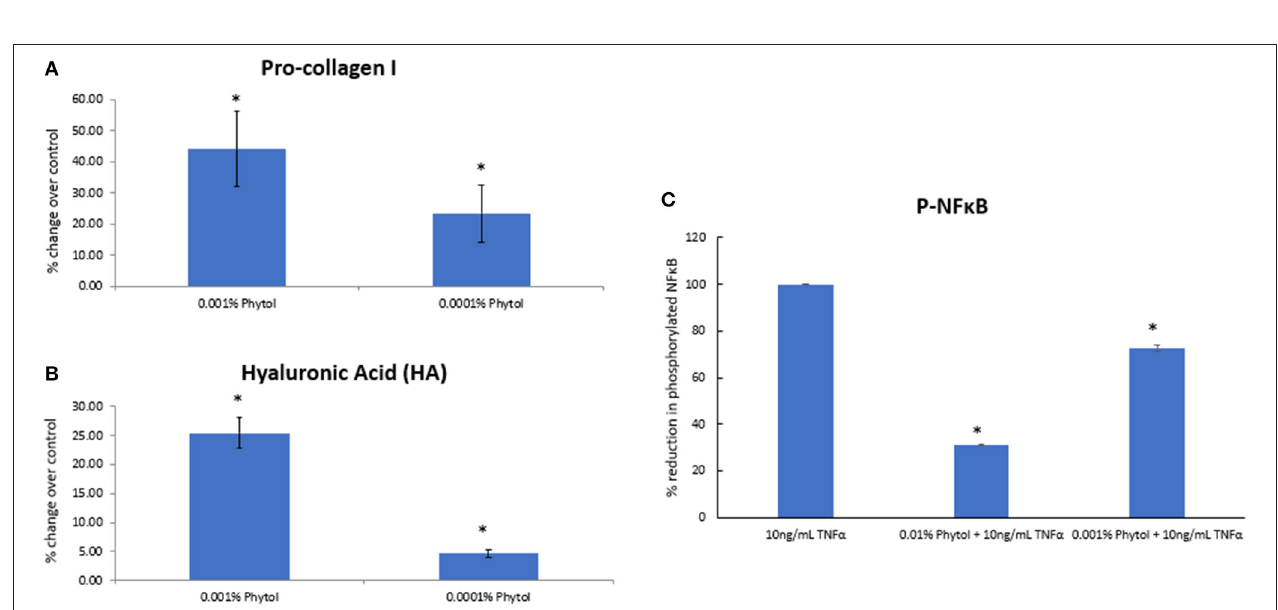
FIGURE 4 | The effect of phytol on pro-collagen I, hyaluronic acid (HA) production in human dermal fibroblasts, and nuclear factor kappa-light-chain-enhancer of activated B cells (NF κ B) phosphorylation in human epidermal keratinocytes. Phytol increased the levels of pro-collagen-I (A) and hyaluronic acid (B) in human primary dermal fibroblasts following 48-h treatment ( p < 0.05). (C) Phytol reduced the levels of phosphorylated NF κ B in tumor necrosis factor α (TNF α )-treated human primary keratinocytes in a dose-dependent manner ( p < 0.05). The assays were performed in triplicate for each sample, and the values represent mean ± SD (standard deviation). *Means p < 0.05 or statistically significant